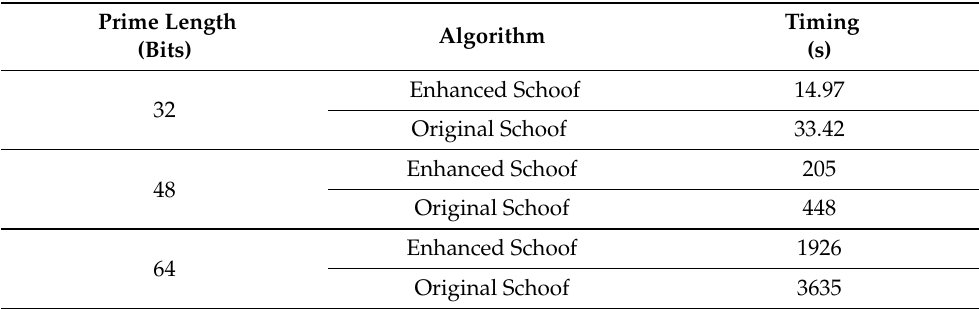
Table 2. Timing comparison between the implementation of our proposed algorithm and the original Schoof